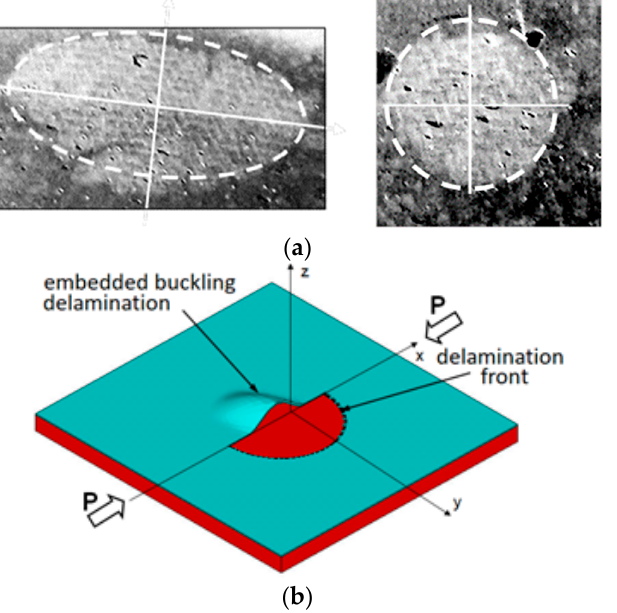
Figure 1. Delaminations: ( a ) white spots indicate the disbonds of the adjacent reinforcement layers which can buckle under compressive loading and propagate; ( b ) cross-section in the xz plane of an embedded buckling circular delamination under compressive loading.